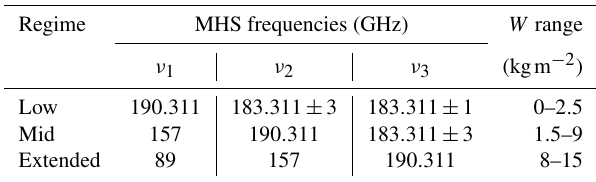
Table 2. MHS frequencies for the low, mid, and extended regimes for the retrievals of water vapour column with typical water vapour column ( W ) ranges. The frequencies ν 1 , ν 2 and ν 3 in each regime are ordered so that τ 1 < τ 2 < τ 3